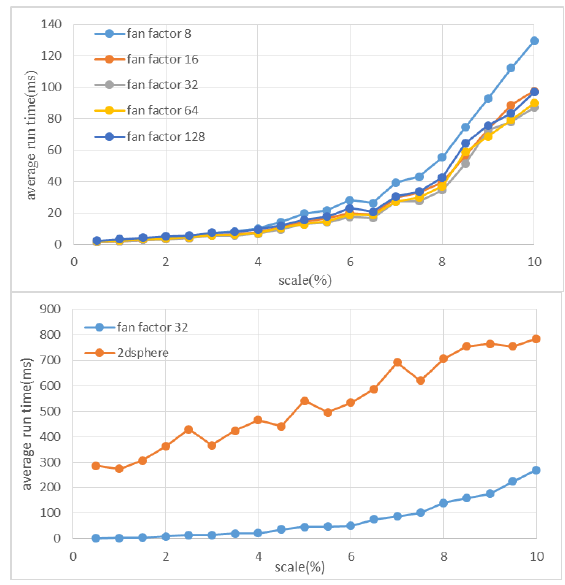
Figure 8. Average run time of range